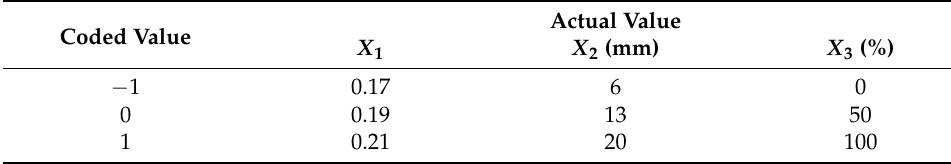
Table 2. Actual and coded values of the independent variables.